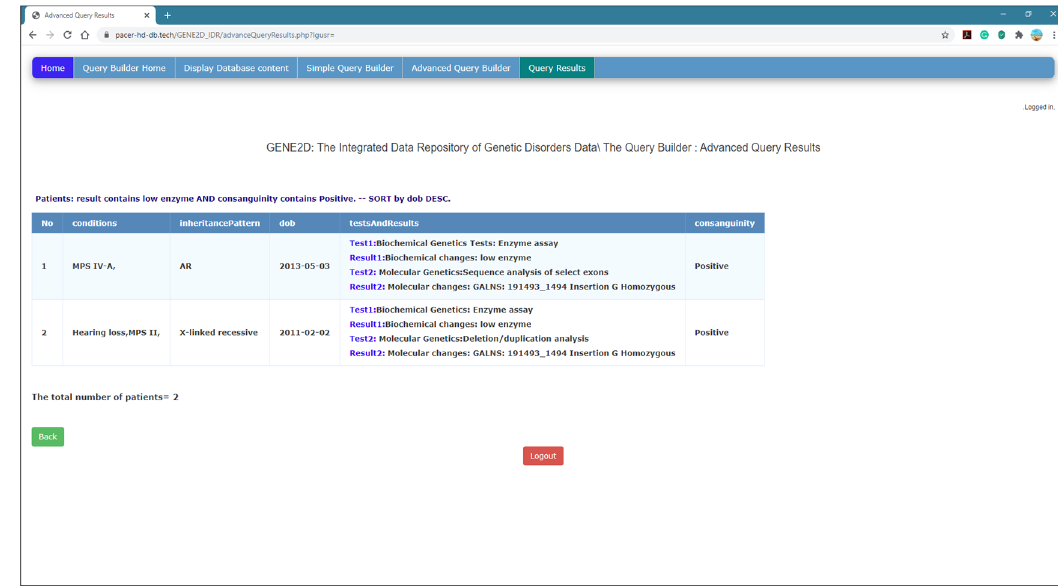
Figure 10. The Advanced Query Results page.